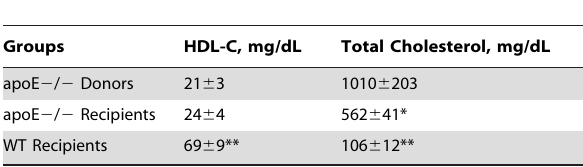
Table 1. Summary of lipoprotein profile of apoE 2 / 2 donors, WT recipients, and apoE 2 / 2 recipients. Values are mean 6 SD of 11 mice per group.